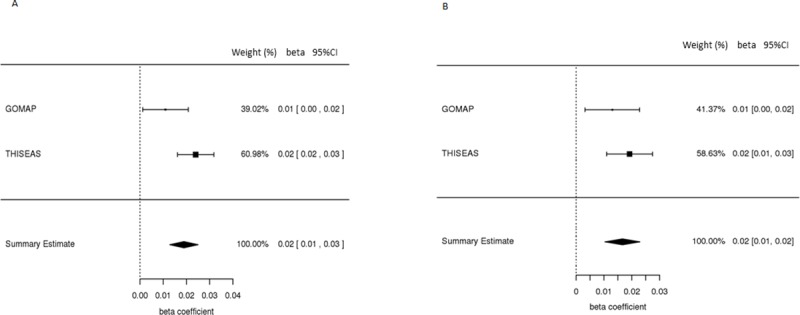
Forest plots of the Meta-Analysis results.Forest plots showing the beta estimates and confidence intervals of the A. GRS and B. wGRS association in the different populations studied in the discovery cohorts and the meta-analysis fixed model results. An inverse variance weighted meta-analysis was performed.